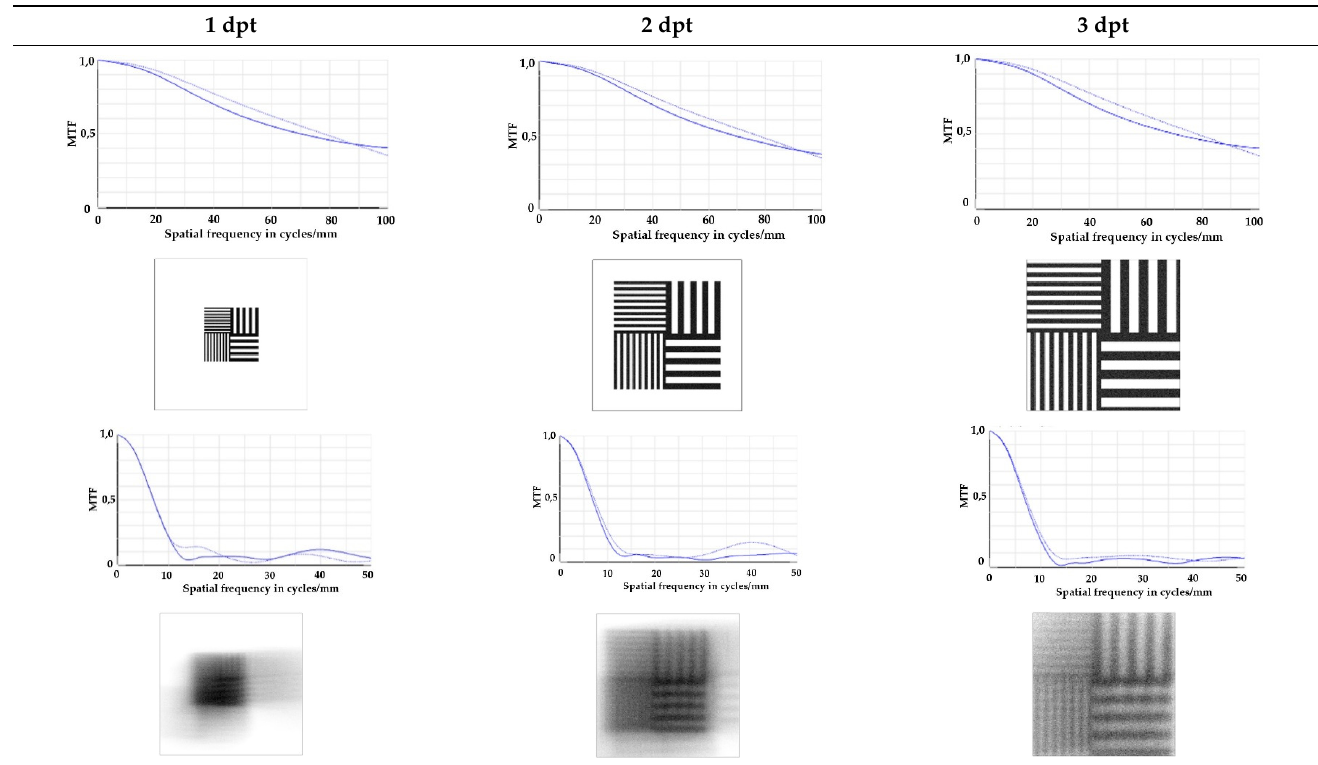
Table 2. Modulation transfer function (MTF) and geometric image analysis of three different adjustments of the rotation optics (1, 2, and 3 dpt) for the nominal surface constraint with a manufacturing tolerance of ±10 µm.